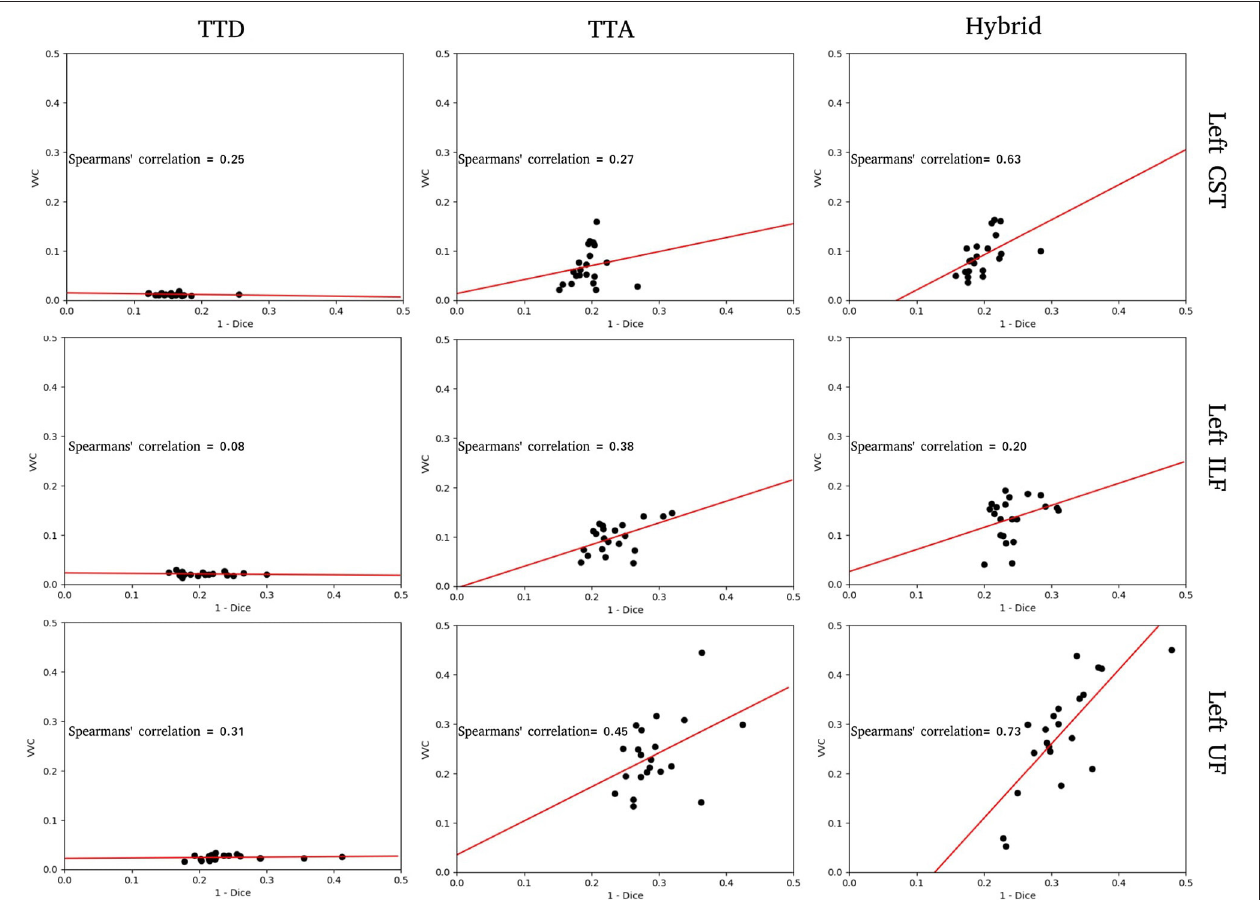
FIGURE 3 | Structure-wise uncertainty as measured by volume variation coefficient (VVC) vs. 1 - Dice for TTD, TTA, and Hybrid approaches in the left CST, ILF, and UF tracts. Spearman’s correlation coefficient indicates the strength of the correlation between VVC and 1 -